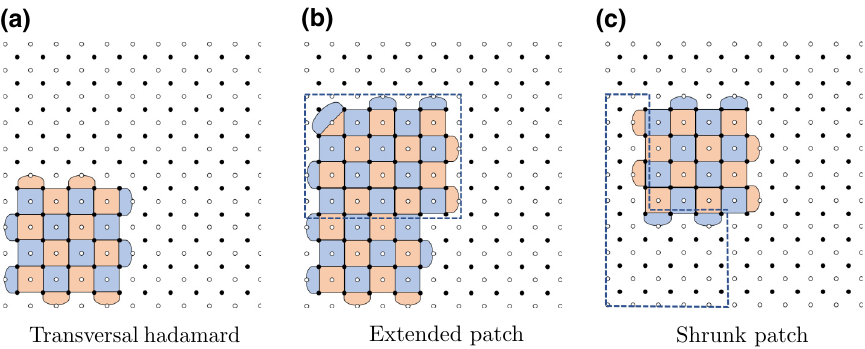
FIG. 17. Implementation of a Hadamard operation in depth 3 with three ancilla patches. (a) A transverse Hadamard operation is applied in depth 0 to each physical data qubit, which switches the arrangement of X and Z stabilizer generators compared to the standard configuration. (b) The patch is extended in depth 1 so that a segment of the standard boundary type is introduced on the right. (c) The patch is shrunk into a standard surface code patch of the form of the top-left corner of the region [see Fig. 15(b)] in depth 1, but with its location shifted by a (code distance) d -independent amount. This allows us to shift the patch into the top-left corner in 0 depth (not shown). Then we move the logical qubit to the bottom-left corner in depth